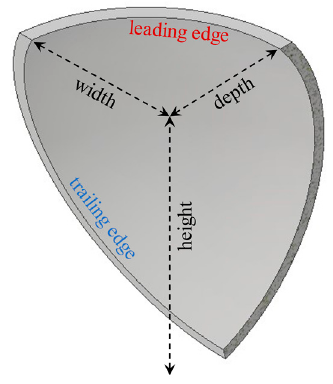
Figure 12. Half of a blade with the height, width, and depth dimensions shown.